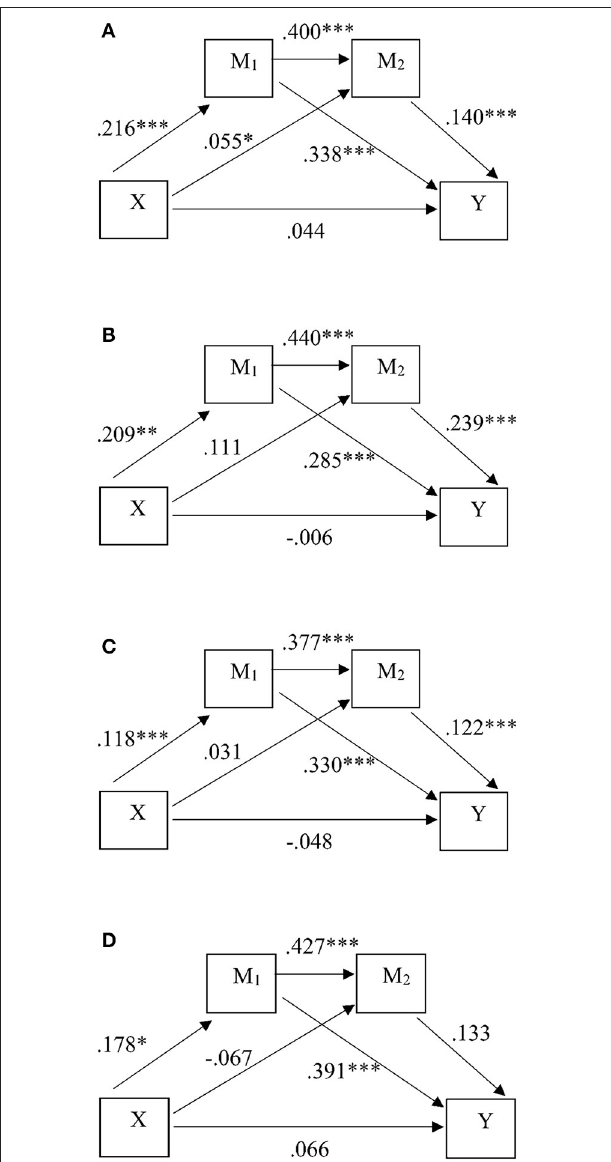
FIGURE 2 | Predictive model standardized effects for the HE student groups: (A) all students ( N = 1,332), (B) students with low resilience ( N = 210), (C) students with normal resilience ( N = 916), and (D) students with high resilience ( N = 206). * significant at p < 0.05, ** significant at p < 0.01, *** significant at p < 0.001, X, resilience; Y, engagement; M1, academic belonging; M2, social integration